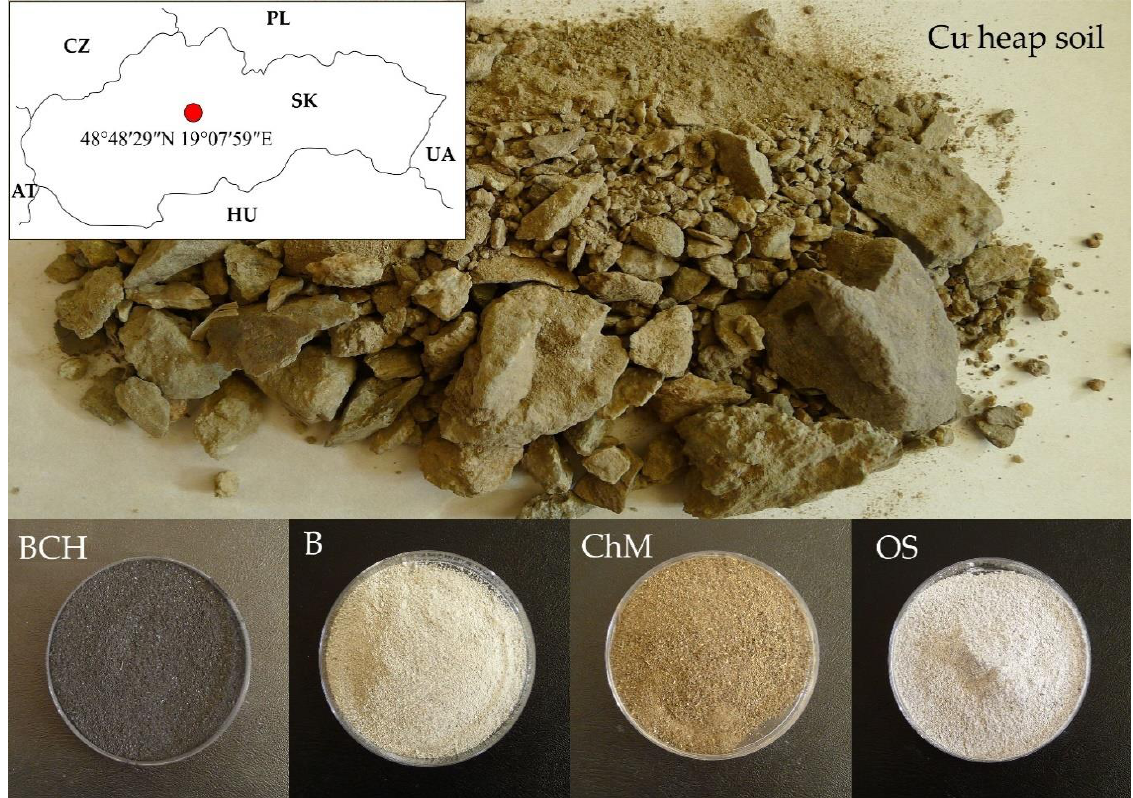
Figure 6. Soil types used in the experiment: Cu heap soil — copper soil; copper soil with sorbents: BCH — biochar, B — bentonite, ChM — chicken manure, OS — organo-zeolitic substrate.